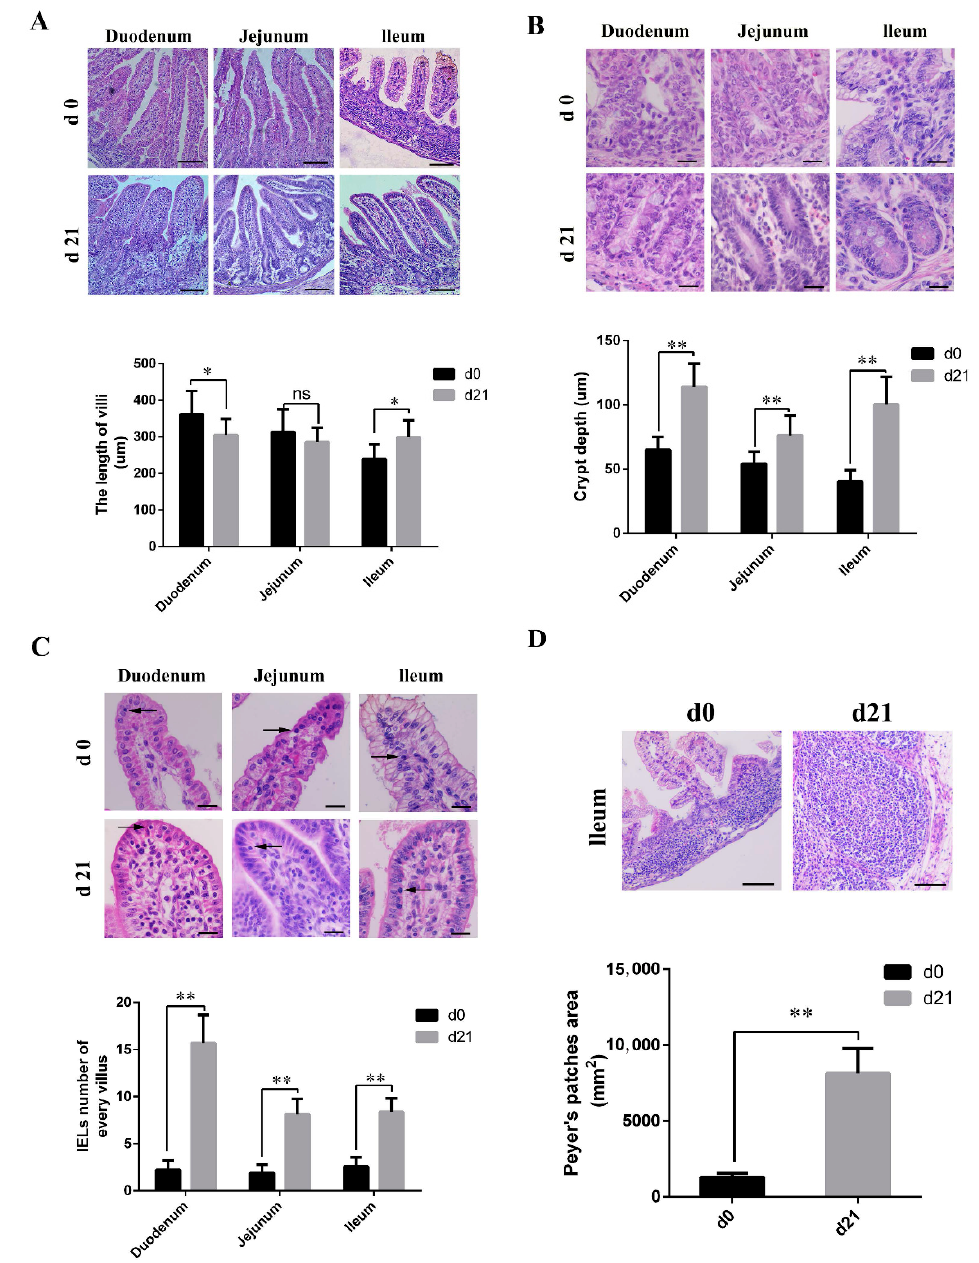
Figure 1. Histological and morphometrical differences between the small intestines of neonatal and weaned piglets. Tissue sections were stained using hematoxylin and eosin and certain parameters were compared between neonatal and weaned piglets. ( A ) Intestinal villus height. Scale bars: 100 µ m. ( B ) Intestinal crypt depth. Scale bars: 20 µ m. ( C ) Intestinal intraepithelial lymphocytes ( → ). Scale bars: 20 µ m. ( D ) Ileal Peyer’s patches. Scale bars: 100 µ m. The certain parameters were calculated in ten random fields. ( n = 10 per group). * 0.01 < p < 0.05 and ** p < 0.01.